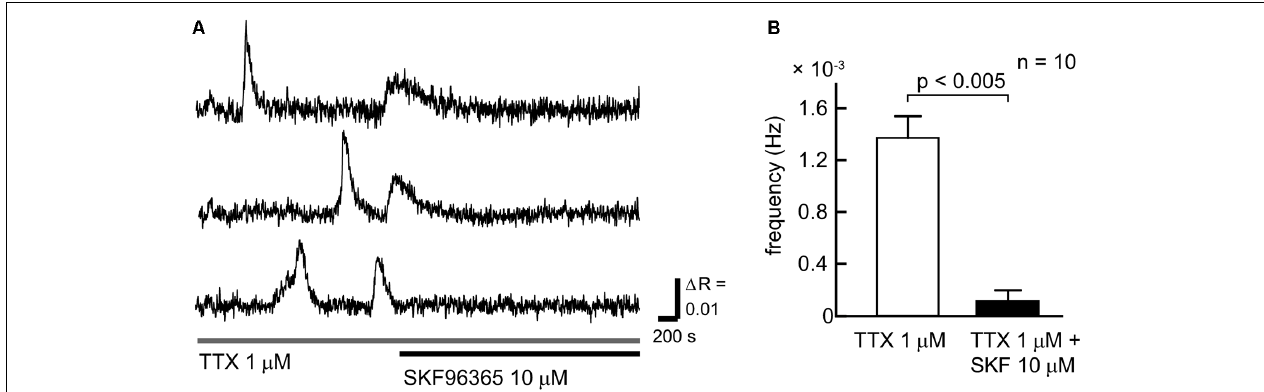
FIGURE 3 | SOCCs were involved in the spontaneous Ca 2 + oscillations. (A) Typical time courses of spontaneous slow Ca 2 + oscillations during the administration of 1 µ M TTX (gray bar) and 10 µ M SKF96365 (black bar). Spontaneous Ca 2 + elevations were not present following the application of SKF96365. (B) Frequencies of [Ca 2 + ] i elevations in the absence (open bar) or presence (solid bar) of SKF96365. The frequency of spontaneous Ca 2 + oscillations was significantly reduced by SKF96365 administration.